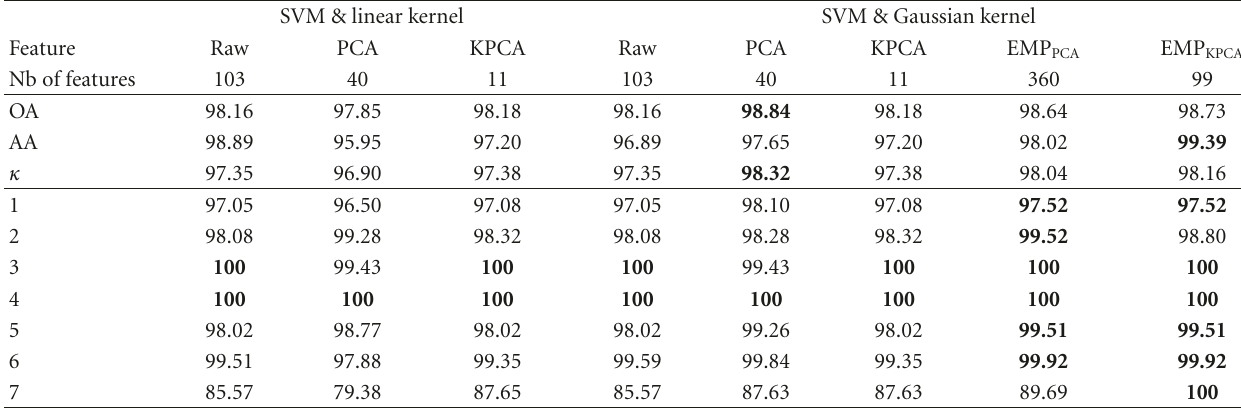
Table 10: Classification results for the Washington DC data set.